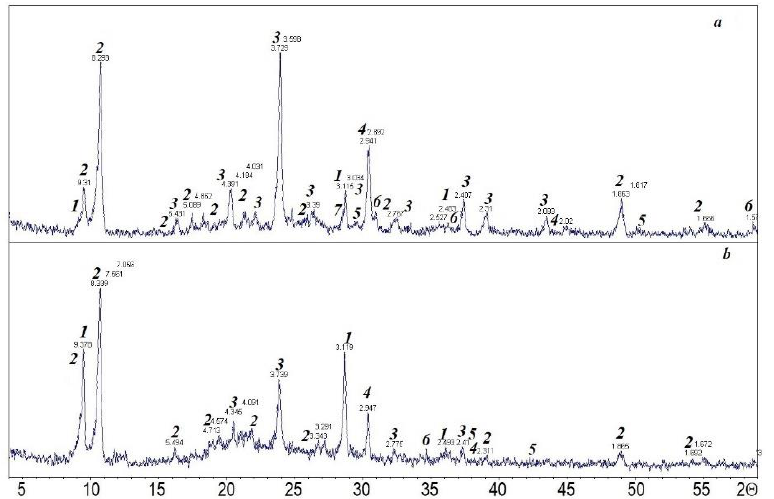
Figure 5. XRD pattern of the clinker after roasting at 450 °C ( a ) and of the leaching residue ( b ). Numbers indicate reflexes: 1—talc; 2—coquimbite; 3—mohrite; 4—pyrrhotite; 5—pentlandite; 6—magnetite; 7—nickel sulfate; 8—chalcocyanite.